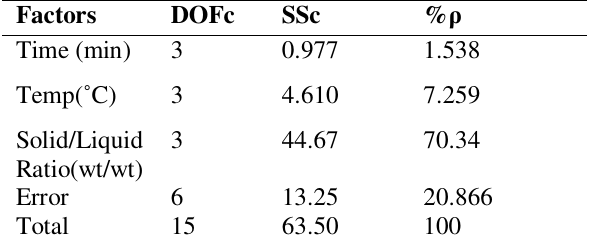
ANOVA for the Palladium leaching by aqua regia solution for each controlled